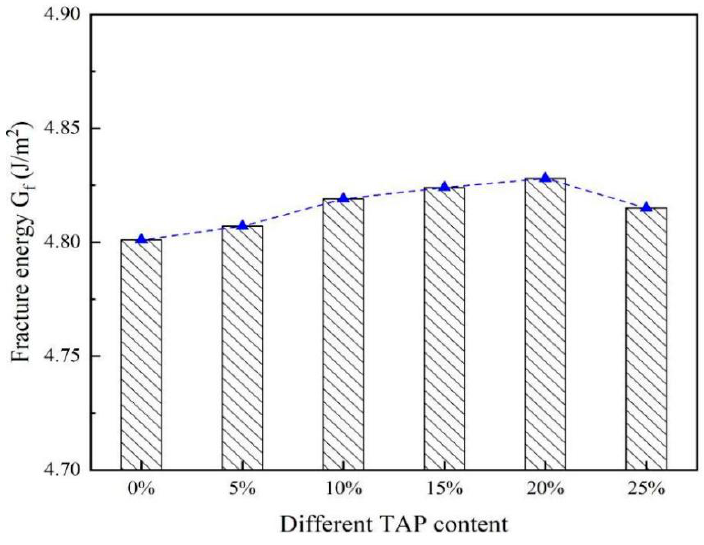
Figure 7. The SCB fracture energy results.